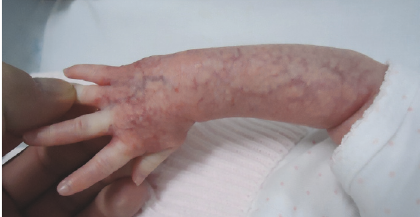
Figure 5: Case 5. An erythematous patch with prominent surface telangiectases on the dorsal arm of a 3-month